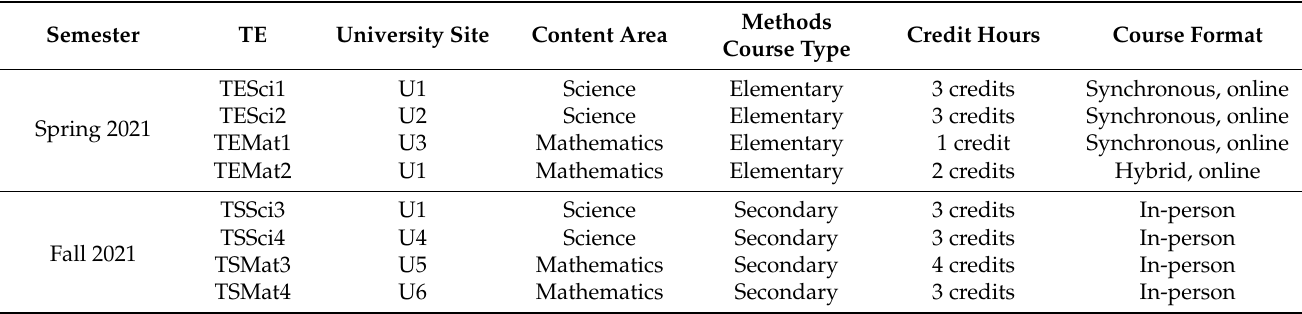
Table 2. Key Characteristics of course for each teacher education site.